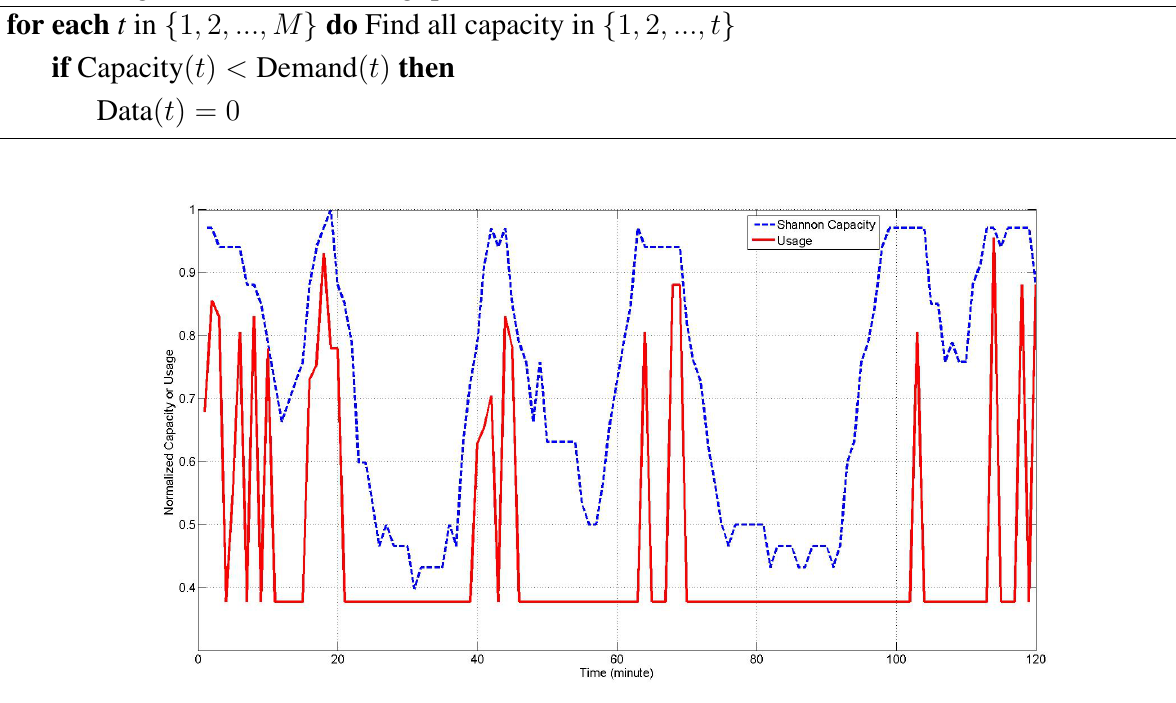
Figure 7. Comparison between normalized channel usage with using the dropping of non-real-time data packets in the event of collision method and calculated point-to-point communication Shannon capacity with respect to